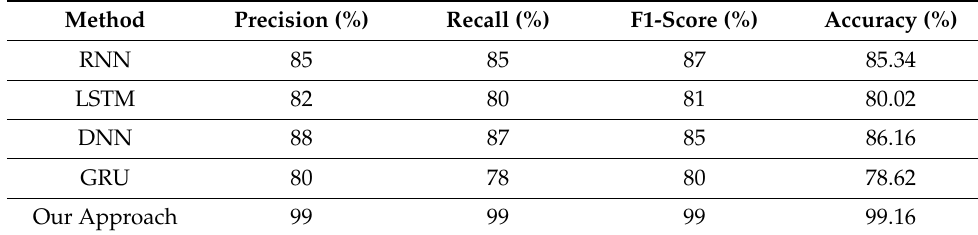
Table 6. Comparisons with state-of-the-art methods.